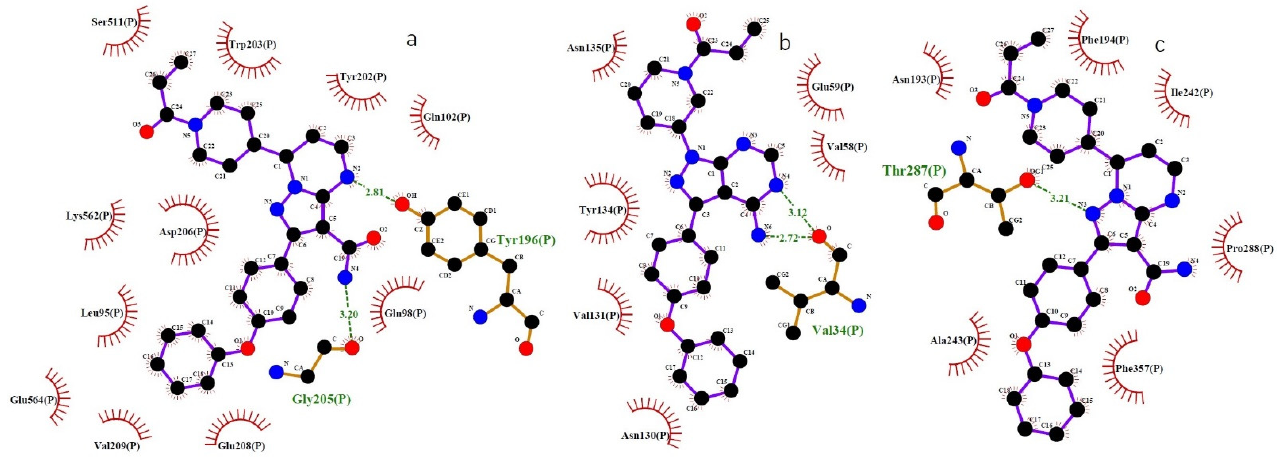
Figure 4. Binding interactions of ibrutinib and zanubrutinib and human proteins (ACE2, BTK and TMPRSS2) predicted by LigPlot. ( a ) Interaction of the OH and O atoms of TYR196 and GLY205 in the ACE2 and the N atom of zanubrutinib. ( b ) Interaction of the O atom of VAL34 in BTK and the N atom of ibrutinib. ( c ) Interaction of the OG1 atom of THR287 in TMPRSS2 and the N atom of zanubrutinib. ACE2—angiotensin-converting enzyme 2; BTK—Bruton’s tyrosine kinase; TMPRSS2—transmembrane serine protease 2; O—oxygen; N—nitrogen; blue lines—ligand bonds; orange lines—non-ligand bonds; dotted lines—hydrogen bonds and their length; red semicircles—non-ligand residues involved in hydrophobic contacts; black dots—corresponding atoms involved in hydrophobic contacts.